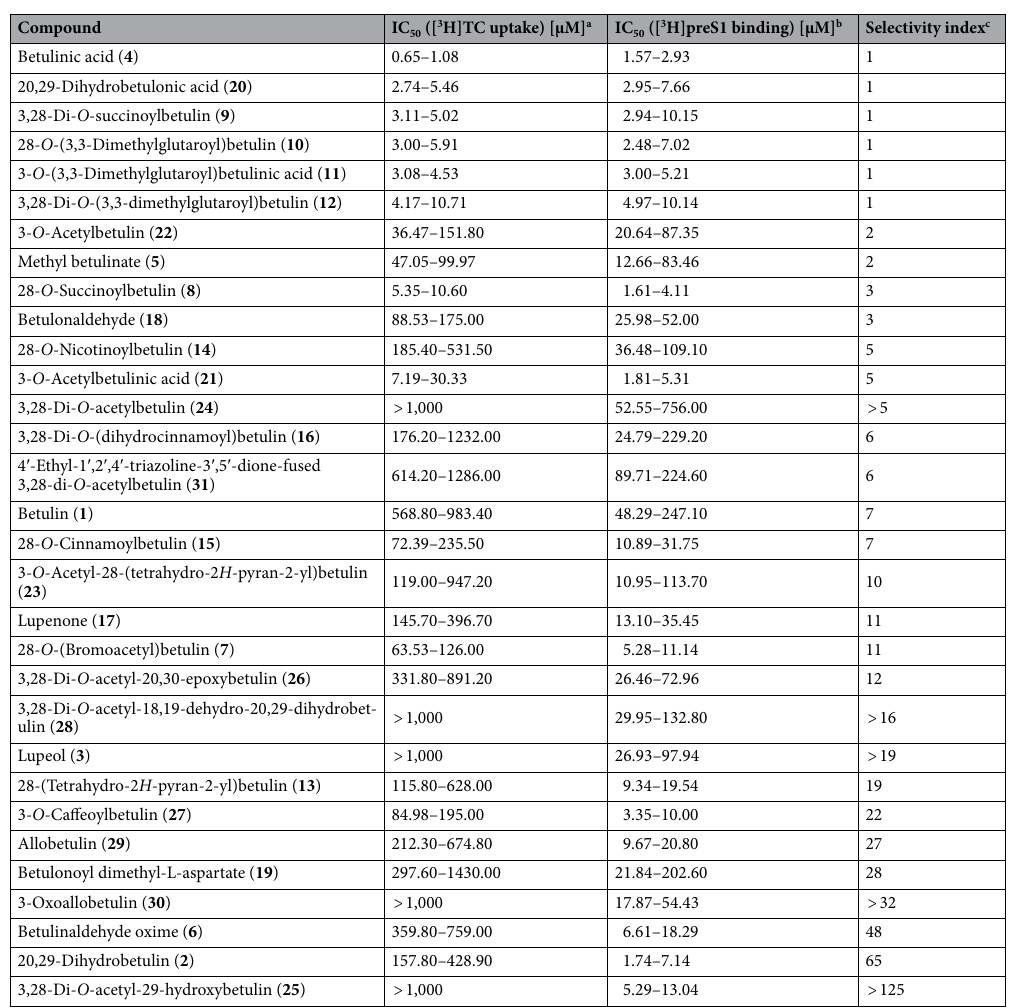
Table 2. The indicated 31 betulin derivatives were analyzed for [ 3 H]TC transport inhibition and [ 3 H] preS1 binding inhibition in NTCP-HEK293 cells. IC 50 values were calculated from a range of five inhibitor concentrations (0.1–1,000 µM) and are listed with their 95% confidence intervals. Selectivity indices for [ 3 H] TC transport inhibition/[ 3 H]preS1 binding inhibition were calculated from the IC 50 means. The higher this index, the more selective the respective inhibitor. a Inhibition of 1 µM [ 3 H]TC uptake; b inhibition of 5 nM [ 3 H]preS1 binding; c calculated from mean IC 50